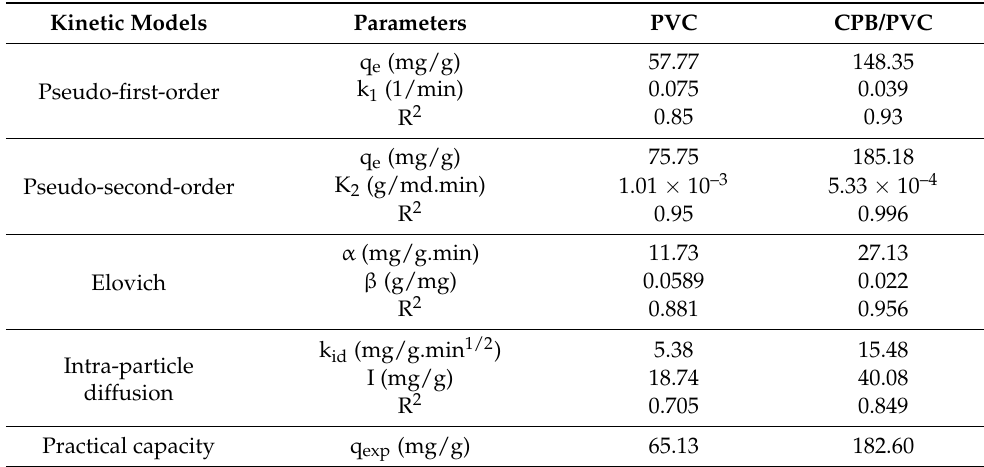
Table 2. Kinetic factors for REE sorption upon PVC and CPB/PVC sorbents. Kinetic